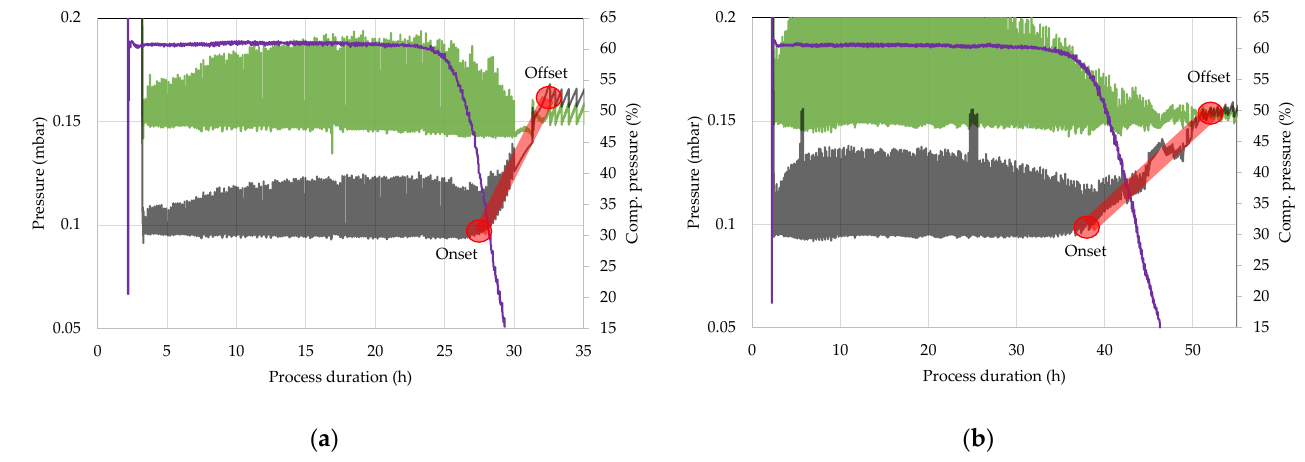
Figure 9. Comparative pressure measurement for ( a ) 5 g/L saccharose and ( b ) 100 g/L saccharose (green — Pirani sensor, black — capacitive sensor, and violet — comparative pressure).